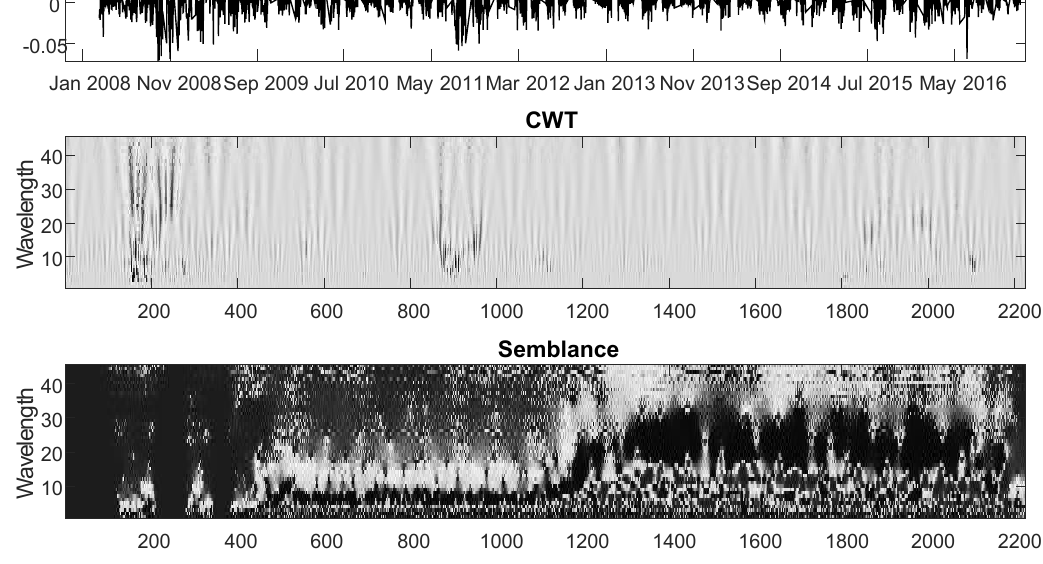
Figure 4. DAX and S&P500